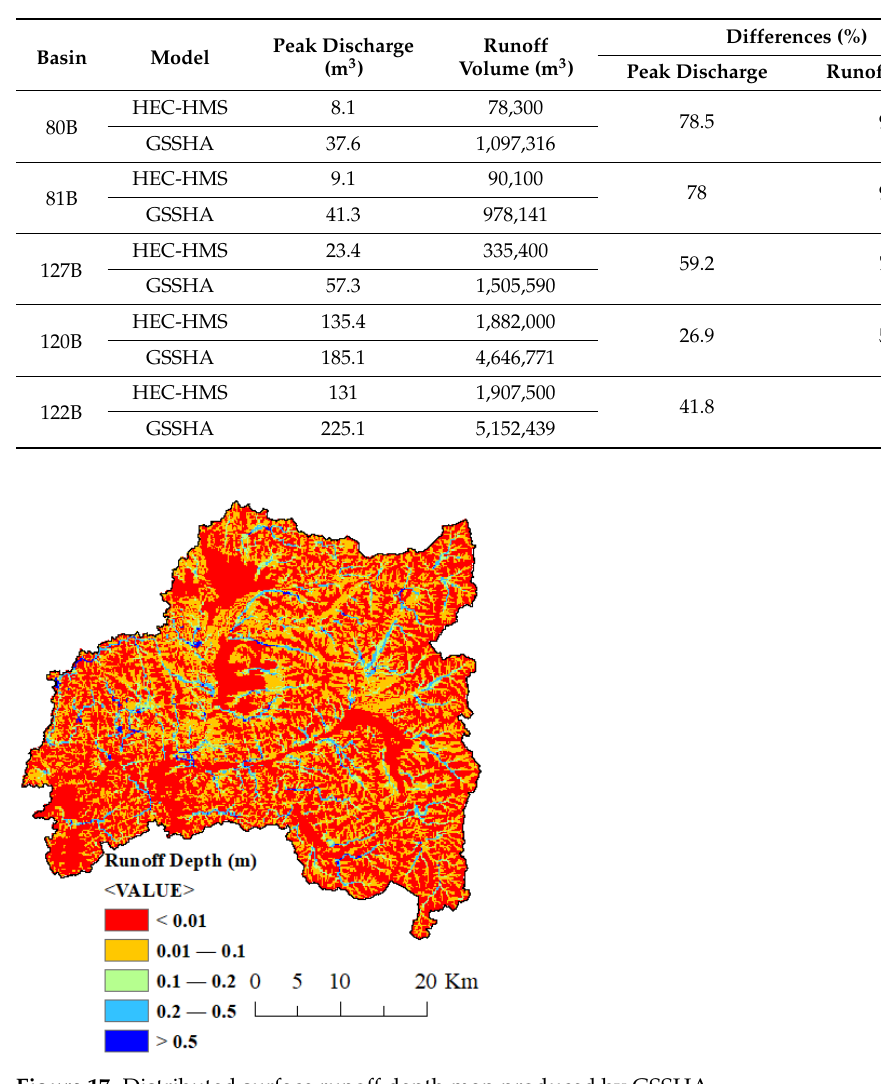
Table 3. Comparison between GSSHA as a reference and HEC-HMS outputs at selected locations.